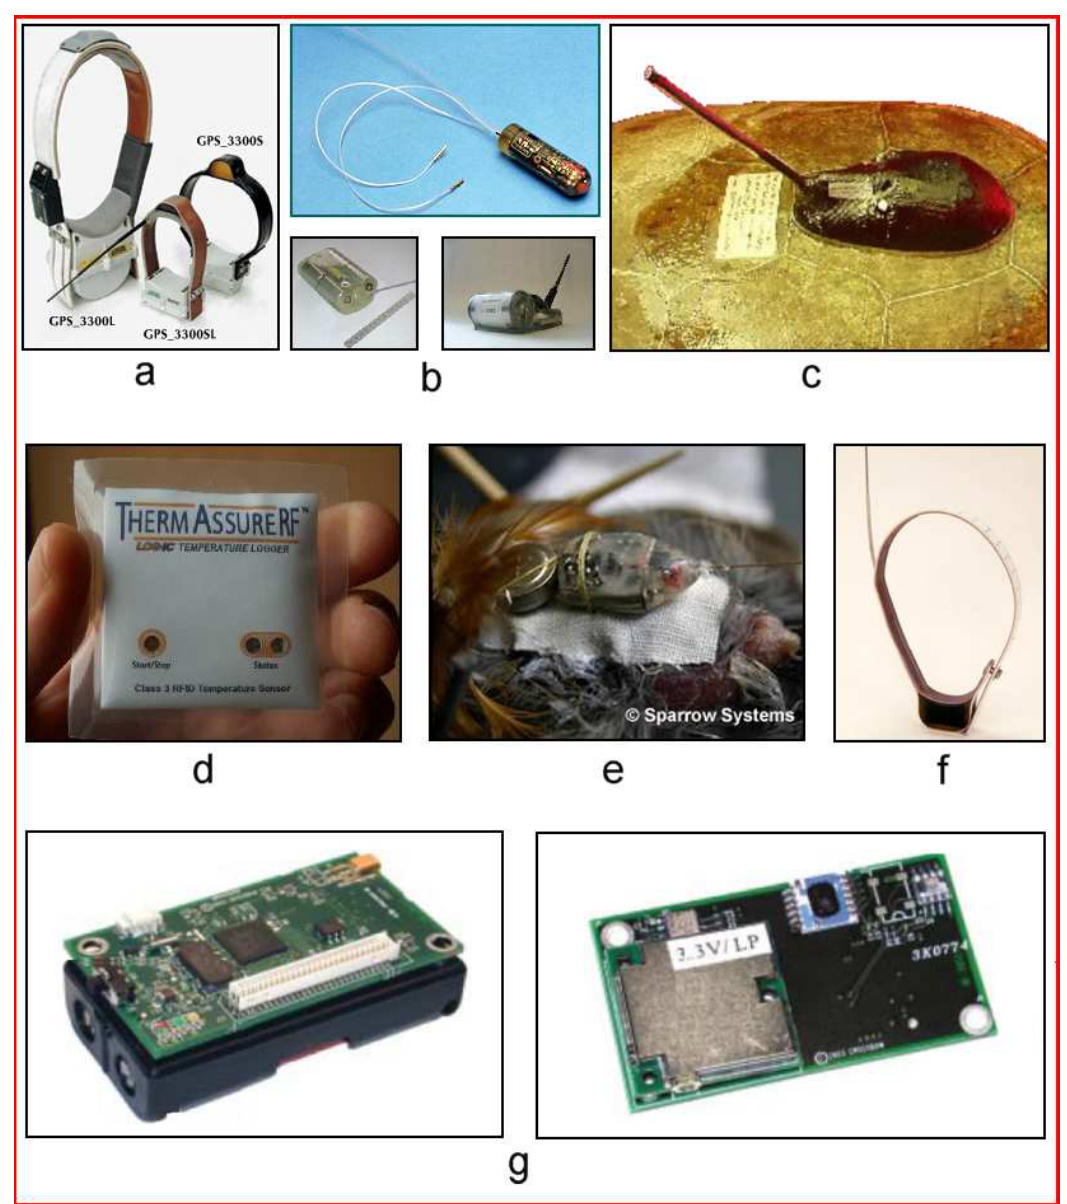
Figure 2. Sample sensors that can be used in the system